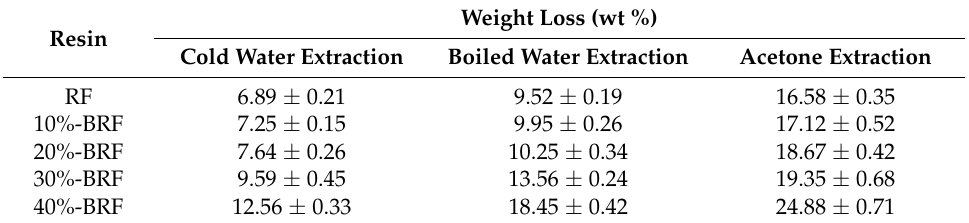
Table 3. Weight loss (WL) of cured resins extracted by cold water, boiled water, and acetone.